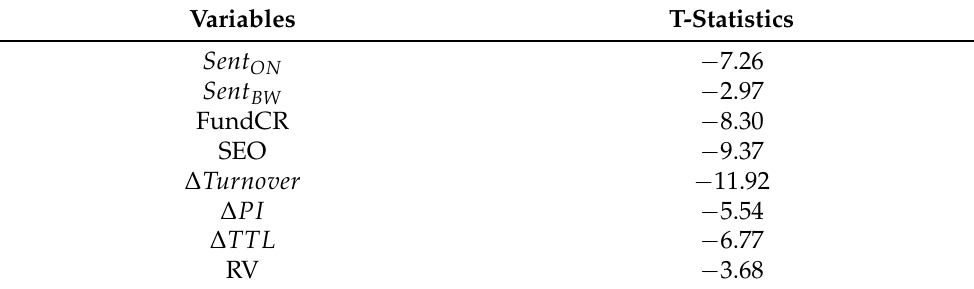
Table 5. Dickey–Fuller tests of